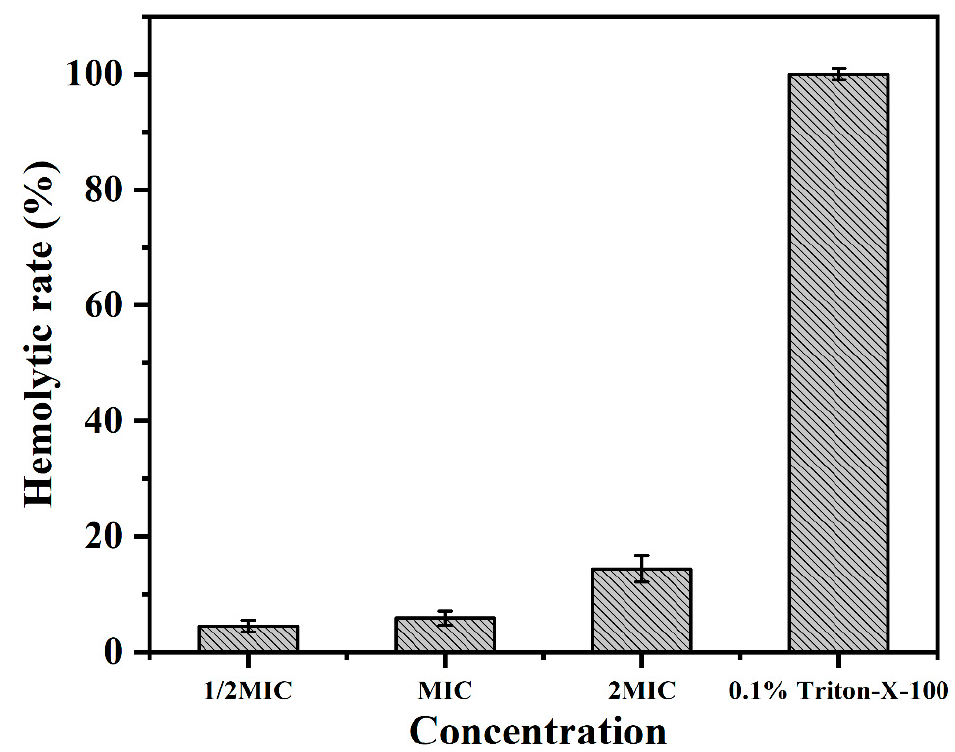
Figure 4. Hemolytic activity of BMGlv2 against rRBCs. For BMGlv2 against E. coli ATCC, MIC was 25922, with a value of 43.75 µ g/mL. The hemolysis values (%) were defined according to the equation: (OD570 of BMGlv2 solution − OD570 of PBS)/(OD570 of 0.1% Triton X-100 − OD570 of PBS) × 100%. Triton X-100 acted as the positive control, PBS acted as the negative control. Results were given as the mean ± SD.